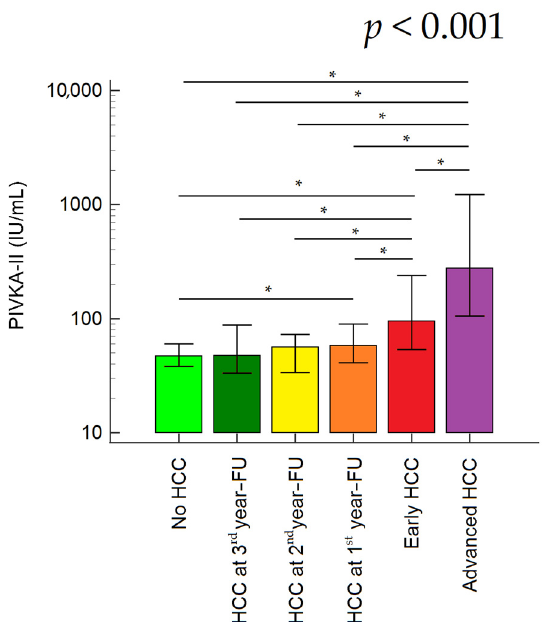
Figure 3. Serum PIVKA-II values in different subgroups of patients. The lowest PIVKA-II values were observed in patients with cirrhosis without HCC occurrence during the FU (47, 38–60 mAU/mL), followed by patients with HCC occurrence during the third (48, 34–89 mAU/mL) and second year of FU (56, 34–73 mAU/mL). PIVKA-II values significantly increased in patients with HCC occurrence during the first year of FU (58, 41–90 mAU/mL), followed by patients with early HCC at baseline (95, 54–240 mAU/mL), and further increased in patients with advanced HCC at baseline (277, 106–1221 mAU/mL). * p value < 0.05 (Mann-Whitney test). Abbreviations: FU, follow-up; HCC, hepatocellular carcinoma; AUC, area under the curve; CI, confidence interval. Finally, in patients with cirrhosis but without HCC at baseline ( n = 982), PIVKA-II > 50 mAU/mL was significantly associated with an increased risk of HCC development during the FU (HR = 1.74, 95% CI 1.21–2.51; p = 0.003). Consistently, the cumulative incidence of HCC in the 605 patients with baseline PIVKA-II ≤ 50 mAU/mL was significantly higher as compared to HCC occurremce in the 377 patients with baseline PIVKA-II > 50 mAU/mL (8.6% vs. 17.5%, Log-rank test, p = 0.003) (Figure 4A). Conversely, we did not observe an association between HCC occurrence and a PIVKA-II > 40 mAU/mL (HR = 1.17, 95% CI 0.80–1.73; p = 0.404); indeed, 38 out of 416 (9.1%) patients with baseline PIVKA-II ≤ 40 mAU/mL developed HCC as compared to 80 out of 566 (14.1%) patients with baseline PIVKA-II > 40 mAU/mL (Log-rank test, p = 0.404) (Figure 4B).